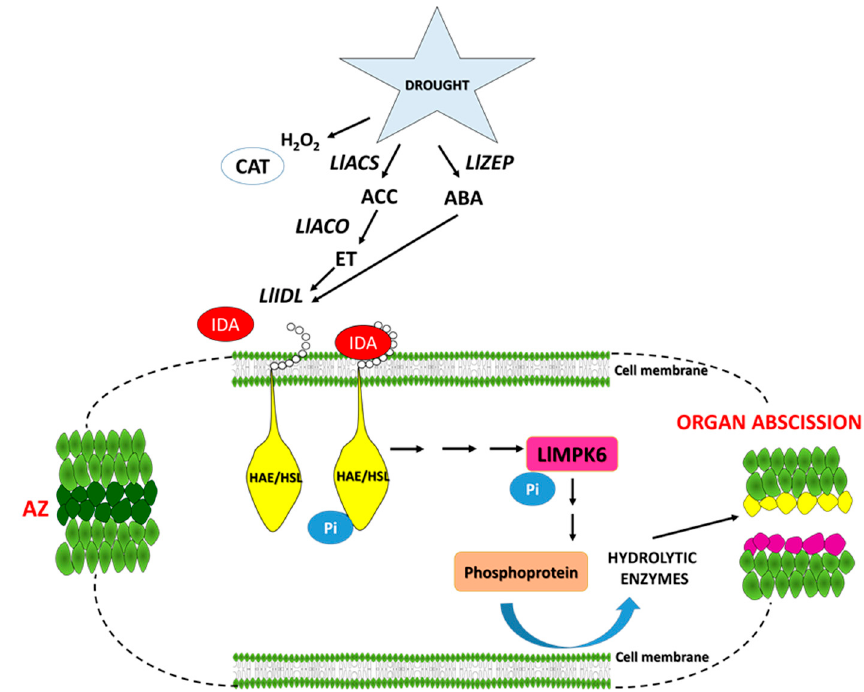
Figure 10. Hypothetical model of floral abscission zone functioning under drought stress in yellow lupine . The precise description is in the text.